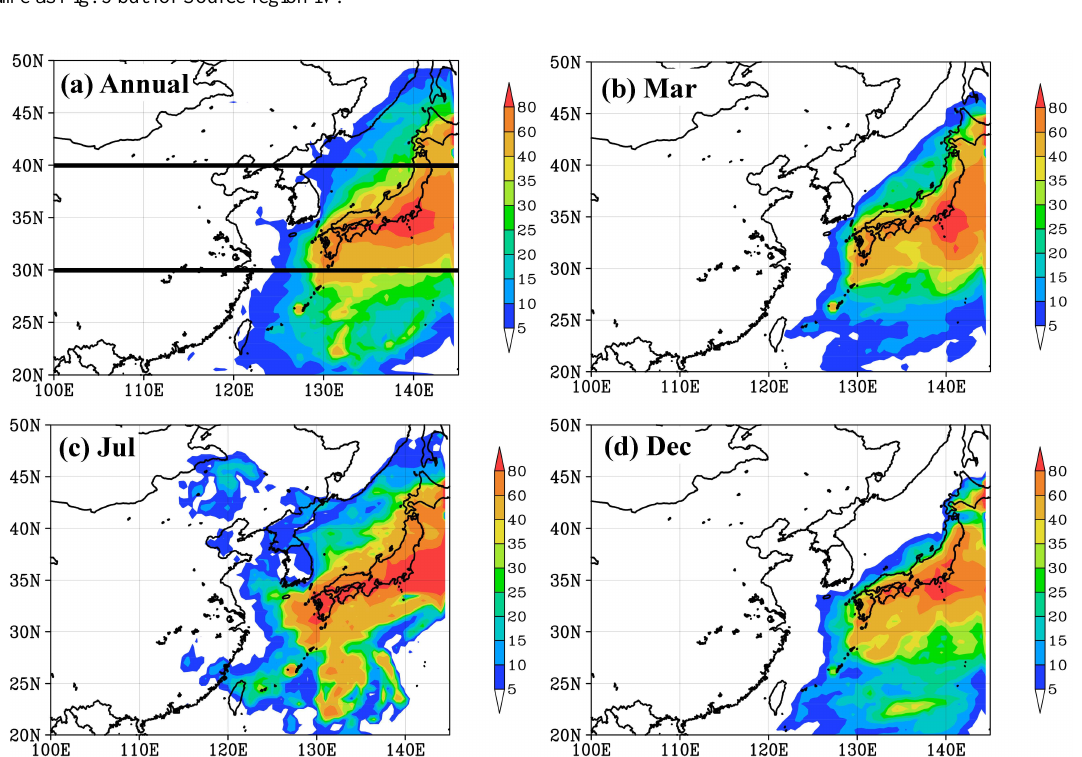
Fig. 8. Same as Fig. 5 but for Source region IV.